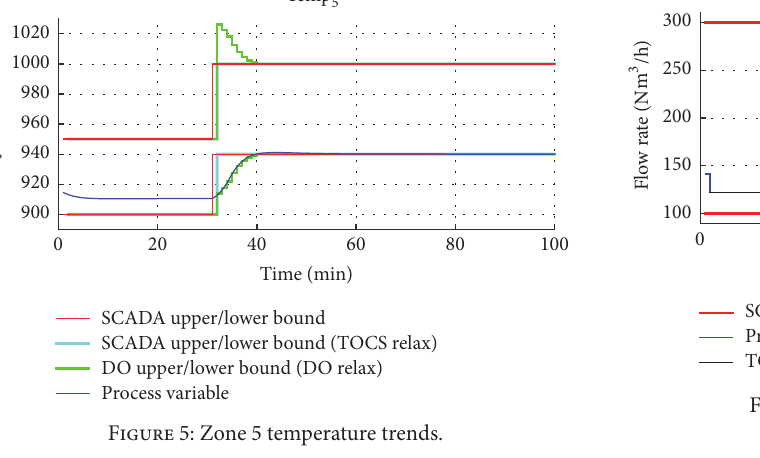
Figure 5: Zone 5 temperature trends.